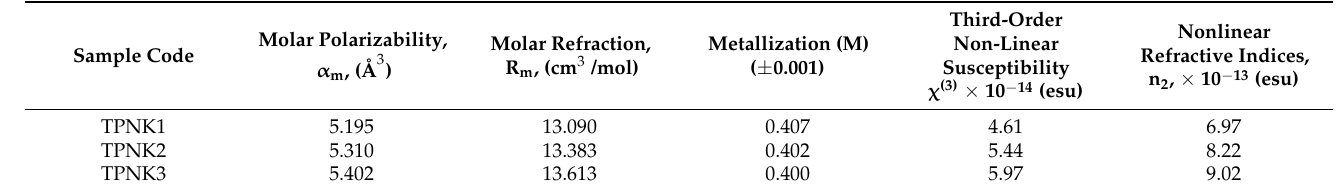
Table 3. The electronic polarizability ( α m ), molar reflection (R m ), and the metallization (M) of the studied glasses.